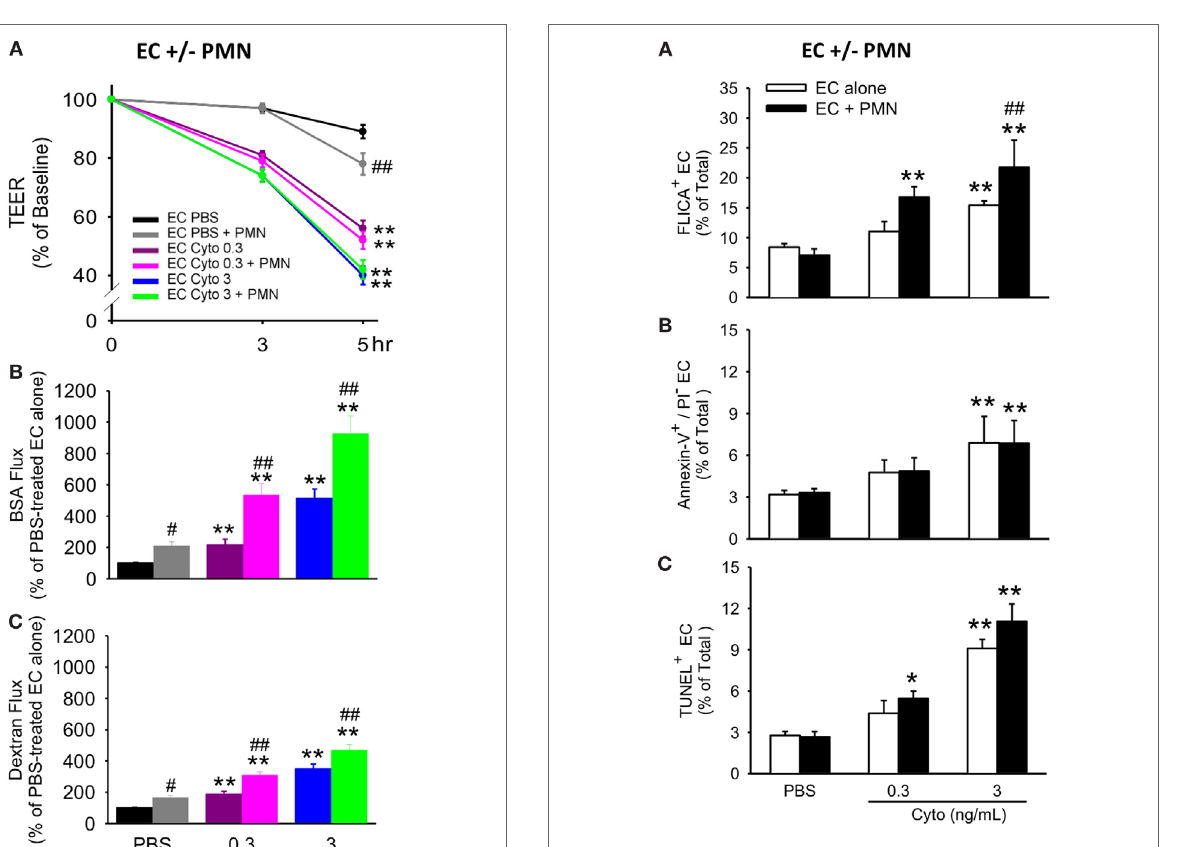
FigUre 5 | PMN coculture with PMVEC increases septic caspase activation but does not augment septic PMVEC apoptosis. In isolated PMVEC, only moderate-dose cytomix (3 ng/mL), but not low-dose (0.3 ng/mL), increased the number of apoptotic PMVEC as indicated by three complementary measures: (a) FLICA + cells, (B) Annexin-V + /propidium iodide (PI) − cells, and (c) TUNEL + cells. Cytomix stimulation of PMN–PMVEC cocultures increased PMVEC caspase activation (FLICA + ) at both low- and moderate-doses but had negligible effects on other markers of apoptosis (Annexin-V + /PI − and TUNEL + ). * p < 0.05 and ** p < 0.01 compared with respective PBS-treated group; ## p < 0.01 for PMN + PMVEC compared with PMVEC alone (two-way ANOVA). n = 3–4.